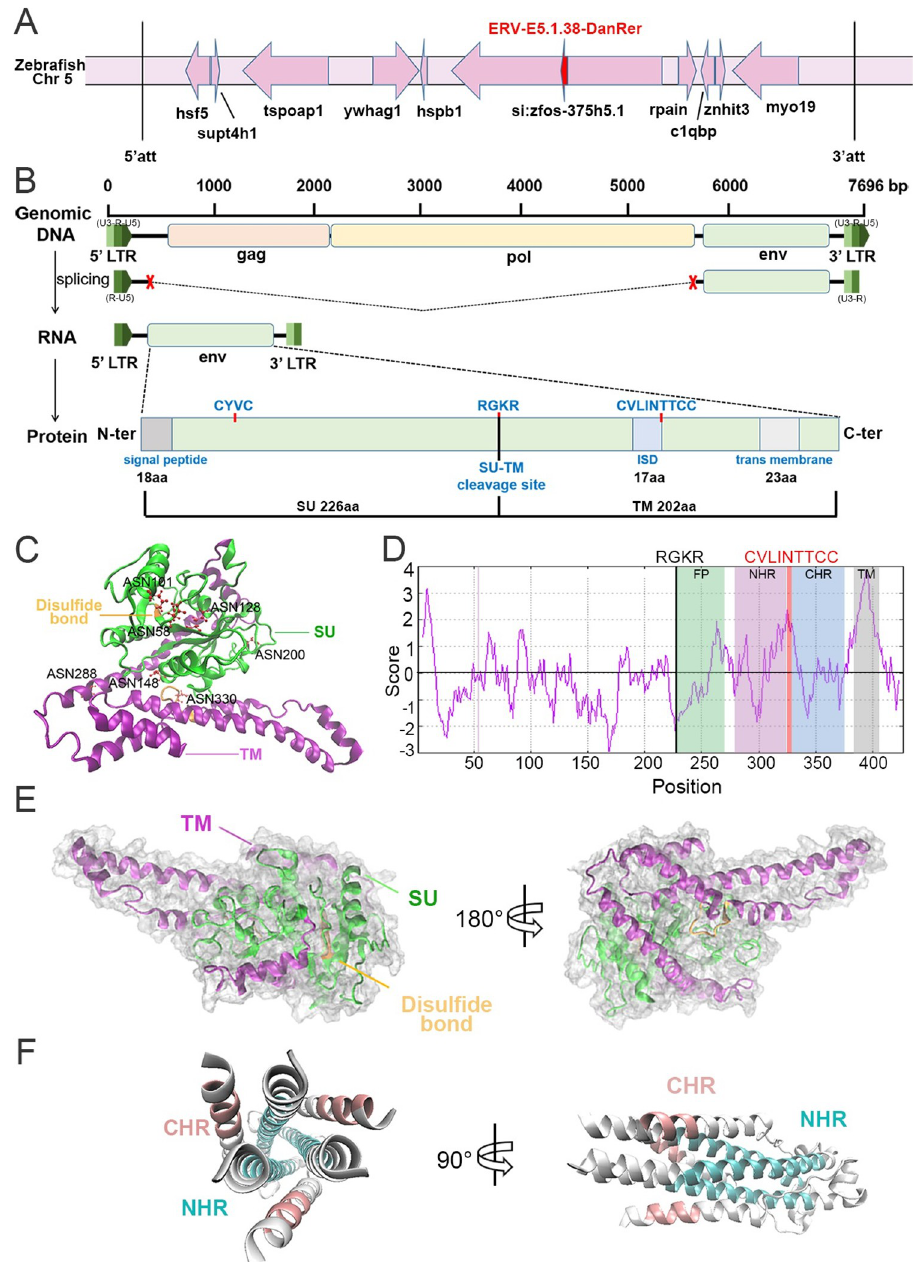
Fig 1. Bioinformatic characterization of ERV-E5.1.38-DanRer element and Env38 molecule. (A) Genomic localization of ERV-E5.1.38-DanRer element in zebrafish. The locus of ERV-E5.1.38-DanRer element on zebrafish chromosome 5 is indicated in red arrow. The ERV-E5.1.38-DanRer is distributed inside si : zfos-375h5 . 1 .The upstream hspb1 , ywhag1 , tspoap1 , supt4h1 , hsf5 and downstream rpain , c1qbp , znhit3 , myo19 genes of ERV-E5.1.38-DanRer are presented, and att means attachment site. (B) Schematic diagram showing the transcription and splicing of env38 gene, as well as the structural characterization of Env38 protein, in which a signal peptide (1–18 amino acid), a furin cleavage site (R/K-X-R/K-R, 227–230 amino acid), an immunosuppressive domain (ISD, 309–325 amino acid), a transmembrane (TM) domain (383–405 amino acid) and conserved C-X-X-C and C-X5/6/7-C motifs are presented. The LTR consists of U3, R, and U5. The transcription of env38 begins at 5’-LTR-R and ends at 3’-LTR-R. (C) The five predicted N-glycosylation sites in SU subunit and two in TM subunit are marked with ASN residues. SU: surface subunit; TM: transmembrane subunit. (D) Hydrophobicity analysis of Env38 protein showed that the fusion peptide next to the furin-cleavage site was partial hydrophobic. FP: fusion peptide; NHR: N-terminal heptad repeats; CHR: C- terminal heptad repeats; TM: transmembrane domain. (E) Tertiary structure of Env38 monomer modeled by